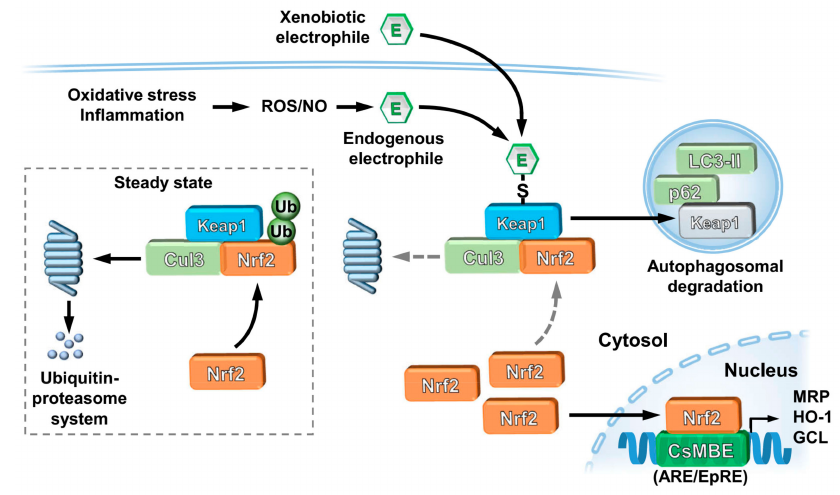
Figure 1. Nrf2 activation mechanisms under electrophilic stresses. Under steady state conditions, Nrf2 is captured by Keap1 and constantly ubiquitinated by Cul3 in the cytosol leading to degradation through the ubiquitin–proteasome system and resulting in the inhibition of Nrf2 translocation from the cytoplasm to the nucleus (inset). Keap1 is modified through its highly reactive cysteine residues by electrophiles that are exposed exogenously or generated endogenously as second messengers, thereby diminishing its activity to hold Nrf2. As a result, Nrf2 newly synthesized translocates into the nucleus and interacts with a partner protein sMaf resulting in formation of a heterodimer that binds to the CsMBE (formerly known as ARE or EpRE), thereby upregulating its downstream genes that are involved in cellular defense (e.g., MRP, HO-1 and GCL). Autophagosomal degradation of Keap1 is also upregulated through its electrophilic modifications. Dotted gray arrows indicate processes disrupted by electrophilic